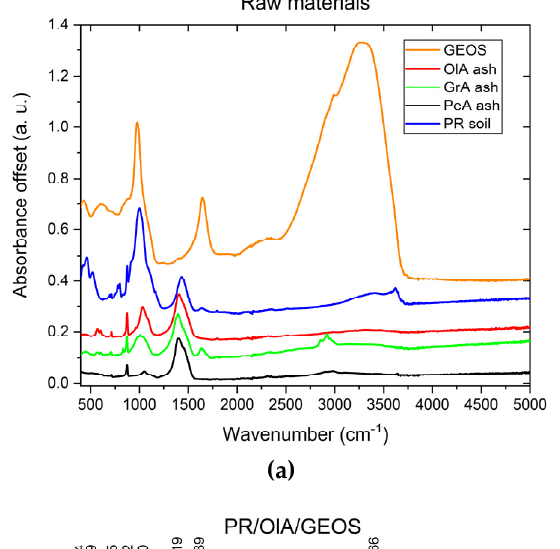
15 of 27 Figure 9 . Fe-SEM photos of treated PR/PeA/GEOS ( a ), PR/OlA/GEOS ( b ), and PR/GrA/GEOS ( c ) after 60 days. The images show C-S-H/C-A-S-H nanocrystals ( a – c ) and honeycomb textures C-S-